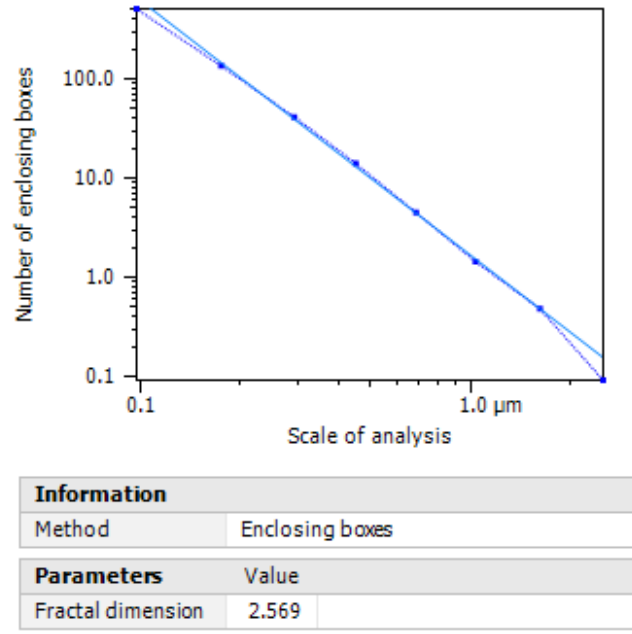
Figure 9. Fractal dimension of TiO 2 scaffolds.